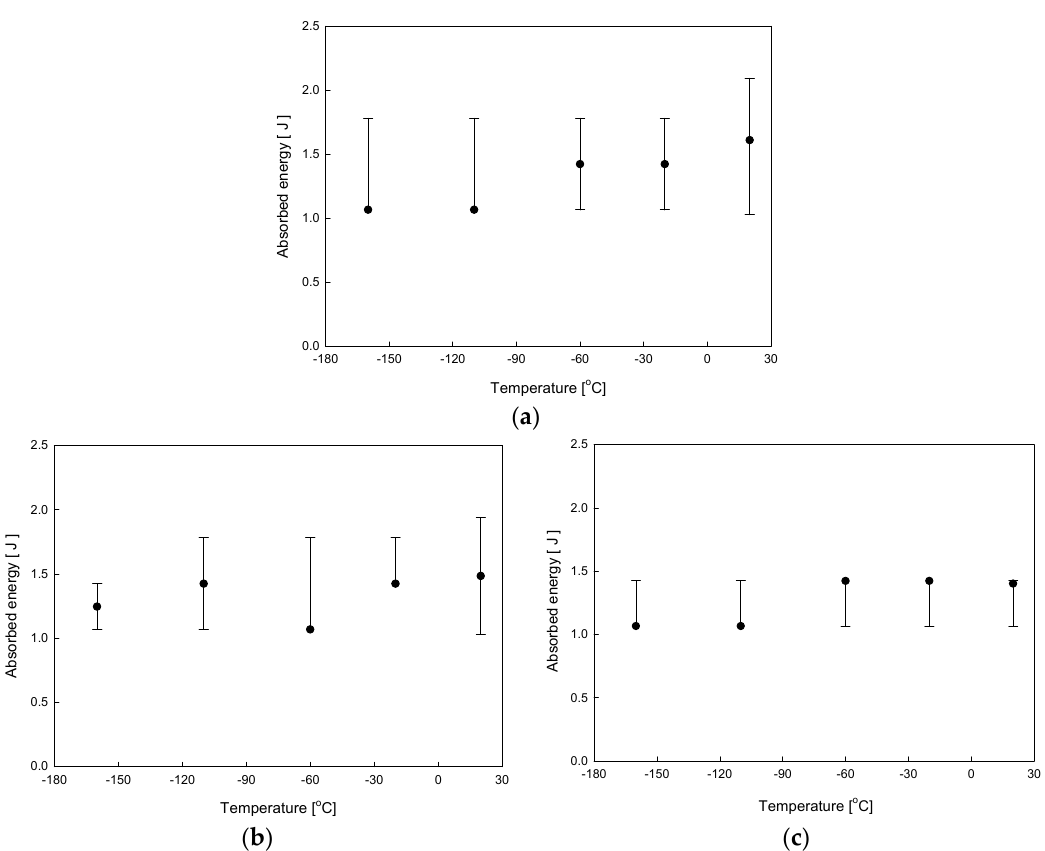
Figure 4. Impact absorbed energy for DCPD with decelerators of ( a ) neat DCPD, ( b ) 1 wt.% and ( c ) 2 wt.%.